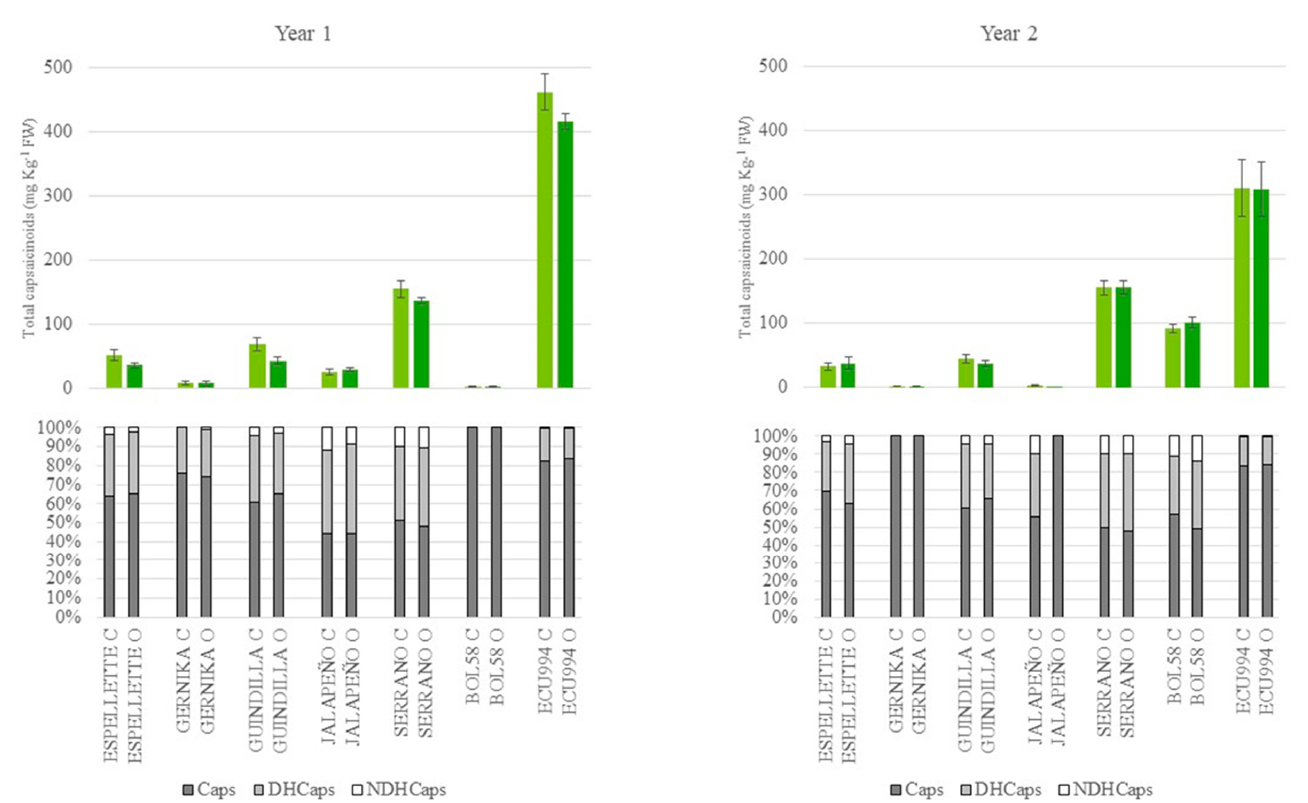
Figure 3. Content of total capsaicinoids (upper, mg kg − 1 of fresh weight) and capsaicinoid profile (lower, % of total capsaicinoids, grey = capsaicin, pale grey = dihydrocapsaicin, and white = nordi- hydrocapsaicin) at the green-ripe stage for the accessions evaluated under conventional (pale green or C) and organic (green or O) growing conditions in years 1 and 2. Vertical bars in the upper figures indicate SE intervals for each mean value.